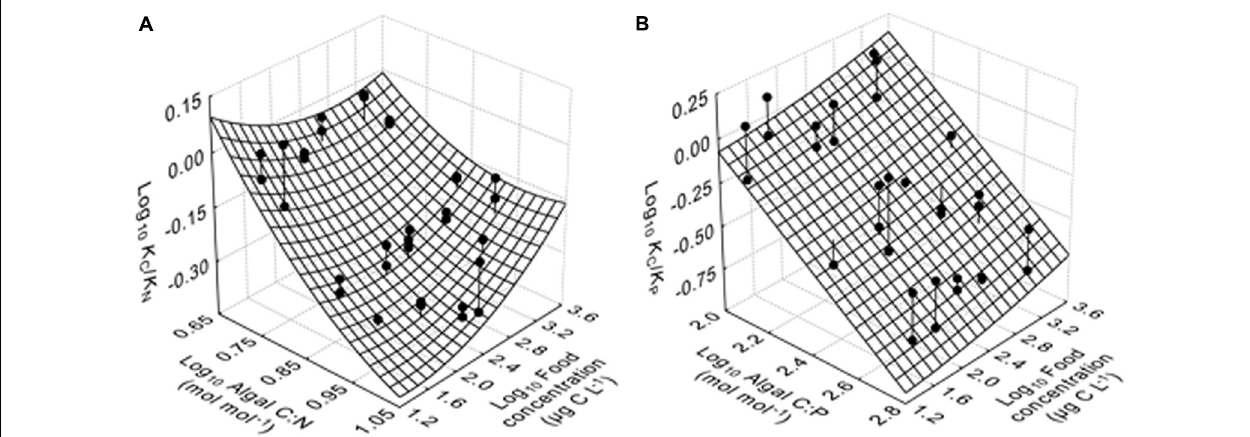
FIGURE 3 | The relative gross growth efficiency (GGE) for carbon and element X ( K C / K X ) (here, X = N or P) as functions of algal C:X ratio and food quantity. (A) The relative GGE for carbon and nitrogen ( K C / K N ) as a function of algal C:N ratio and food quantity, fitted to the second-order quadratic equation, and (B) The relative GGE for carbon and phosphorus ( K C / K P ) as a function of algal C:P ratio and food quantity, fitted to the second-order quadratic equation with only the linear term [algal C:P ratio] and the quadratic term [ food quantity ] 2 . Data of K C / K X , algal C:X and food quantity were transformed using Log 10 ( x ). The mesh grid is the 3D surface plot of the model prediction. Observations are represented by ball-and-stick symbols where the stick is the projection of the observation onto the surface plot.